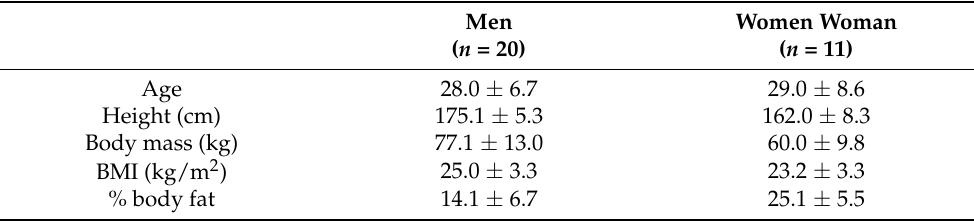
Table 4. Anthropometric characteristics of individuals of both sexes ( n = 31) in the cross-validation group.